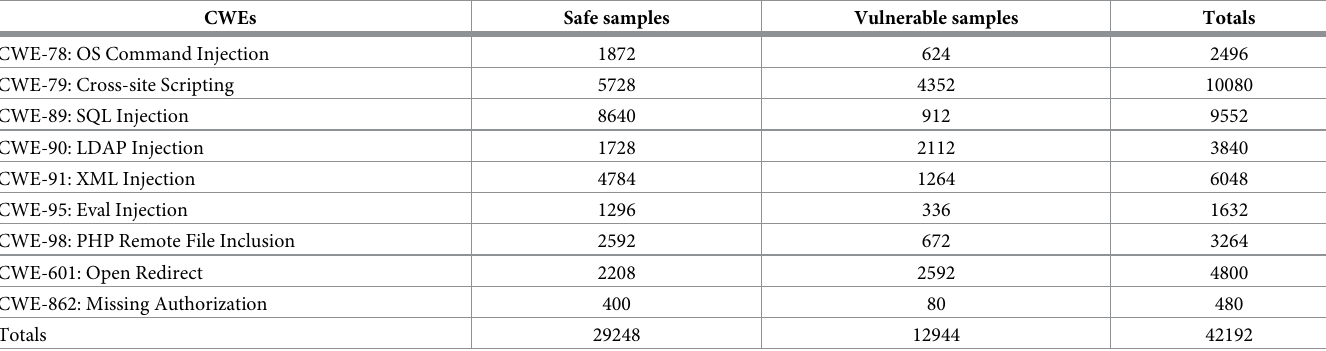
Table 2. The statistics of datasets.